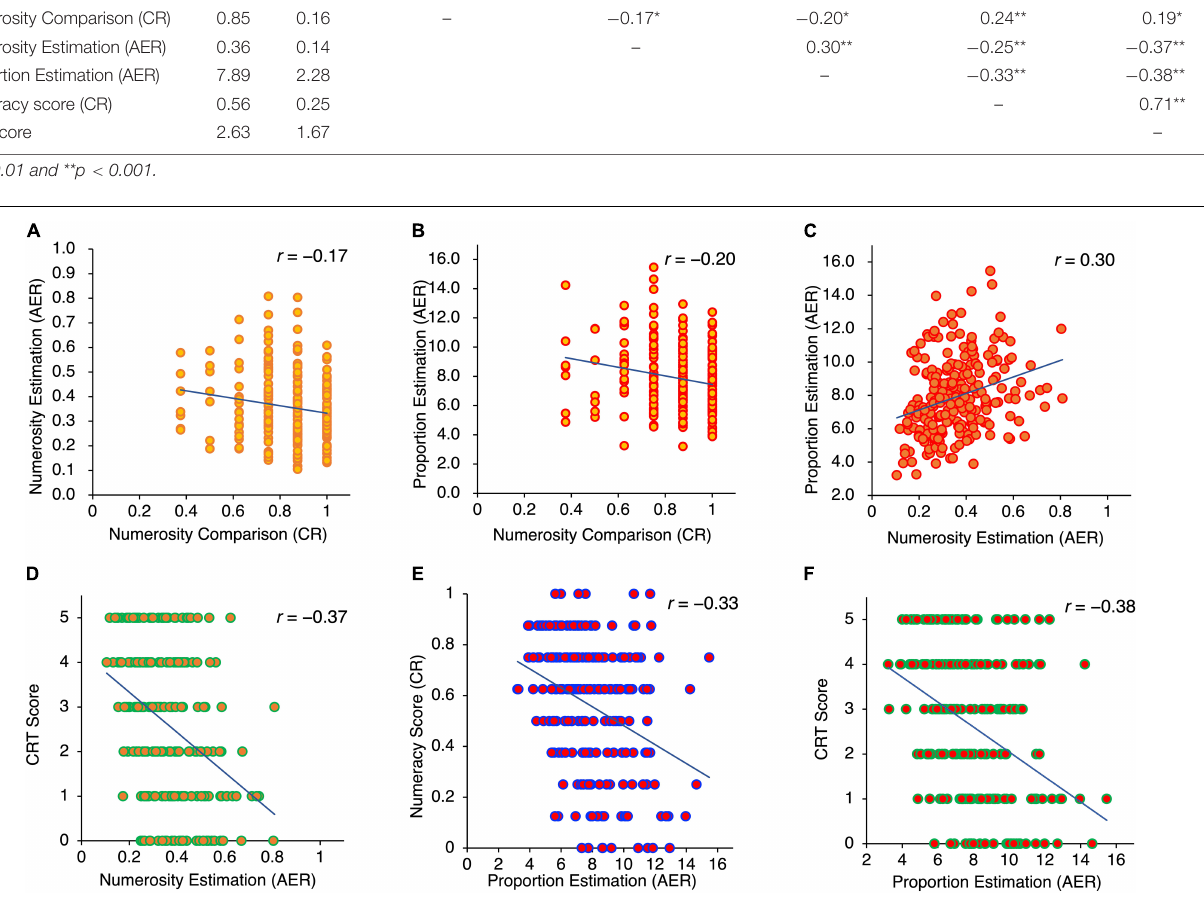
FIGURE 3 | Scatterplots depicting the relation between (A) numerosity comparison (CR) and numerosity estimation (AER), (B) numerosity comparison (CR) and proportion estimation AER), (C) numerosity estimation (AER) and proportion estimation (AER), (D) numerosity estimation (AER) and CRT Score, (E) proportion estimation (ASE) and numeracy score, and (F) proportion estimation (AER) and CRT